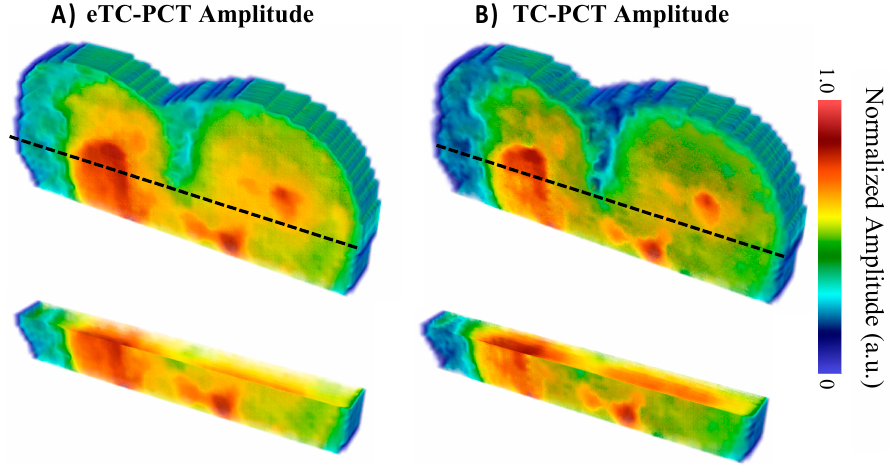
Figure 13. Amplitude reconstructions of the M8 sample (8 days of cariogenic biofilm exposure) using the ( A ) eTC-PCT and ( B ) TC-PCT algorithms with 20 ms slice widths. The amplitudes were normalized between 1.0 and 0 by subtracting the minimum amplitude value and then dividing by the maximum amplitude value within each slice. Volumes are displayed using the method of [31].